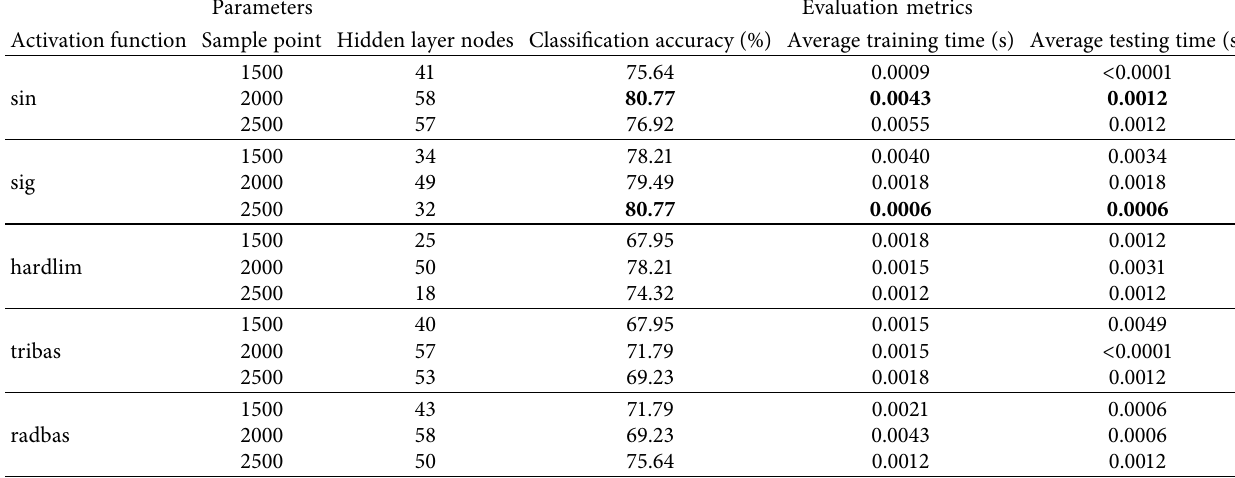
Table 2: Objective classification performance of ELM.